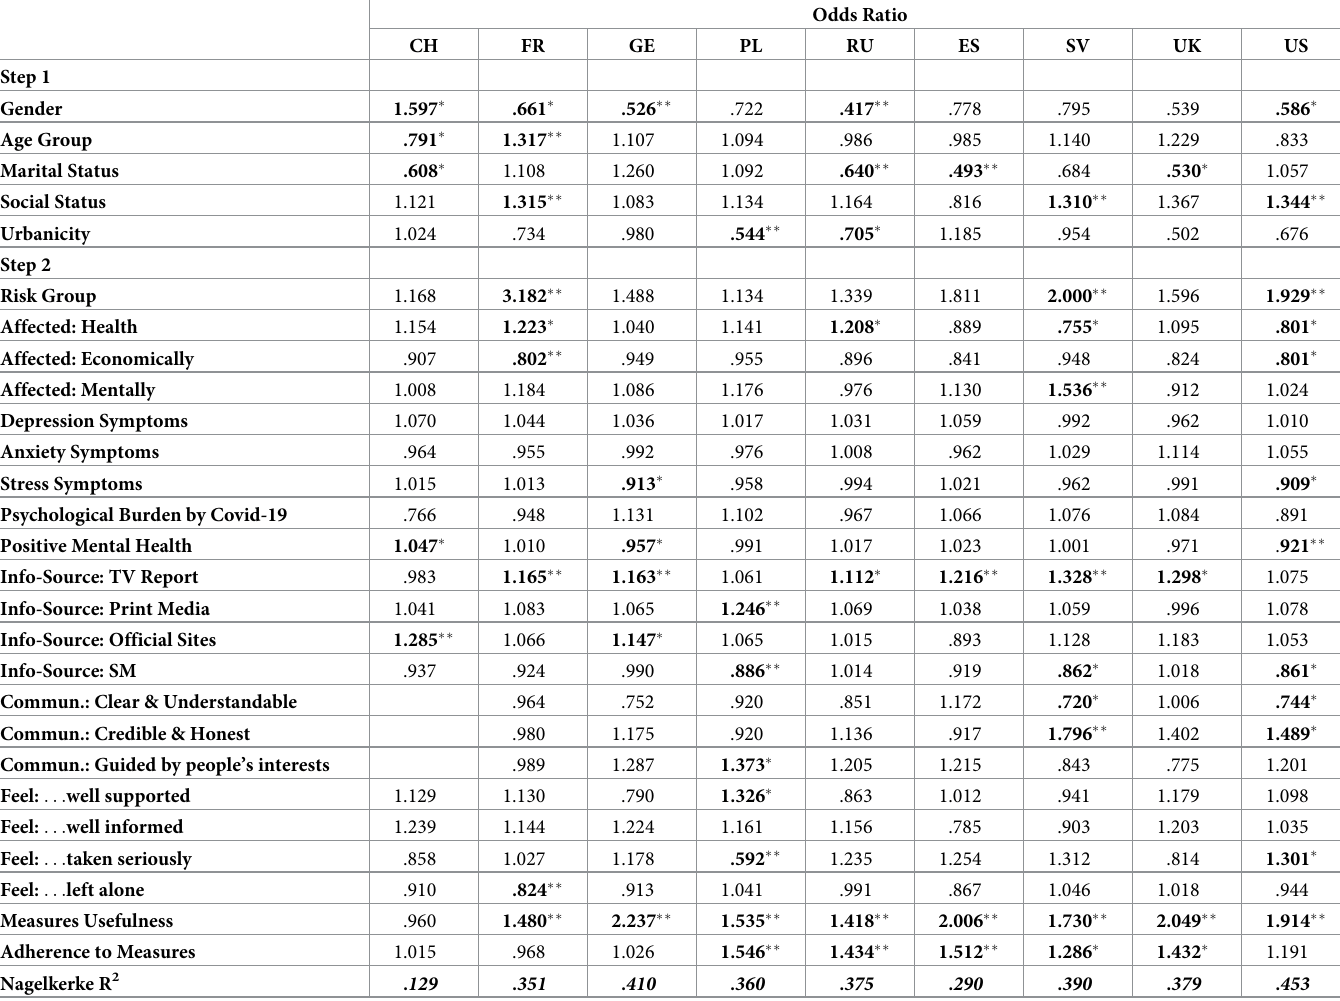
Table 4. Country-specific logistic regression analyses (outcome: Covid-19 vaccination willingness; 0 = no willingness, 1 =